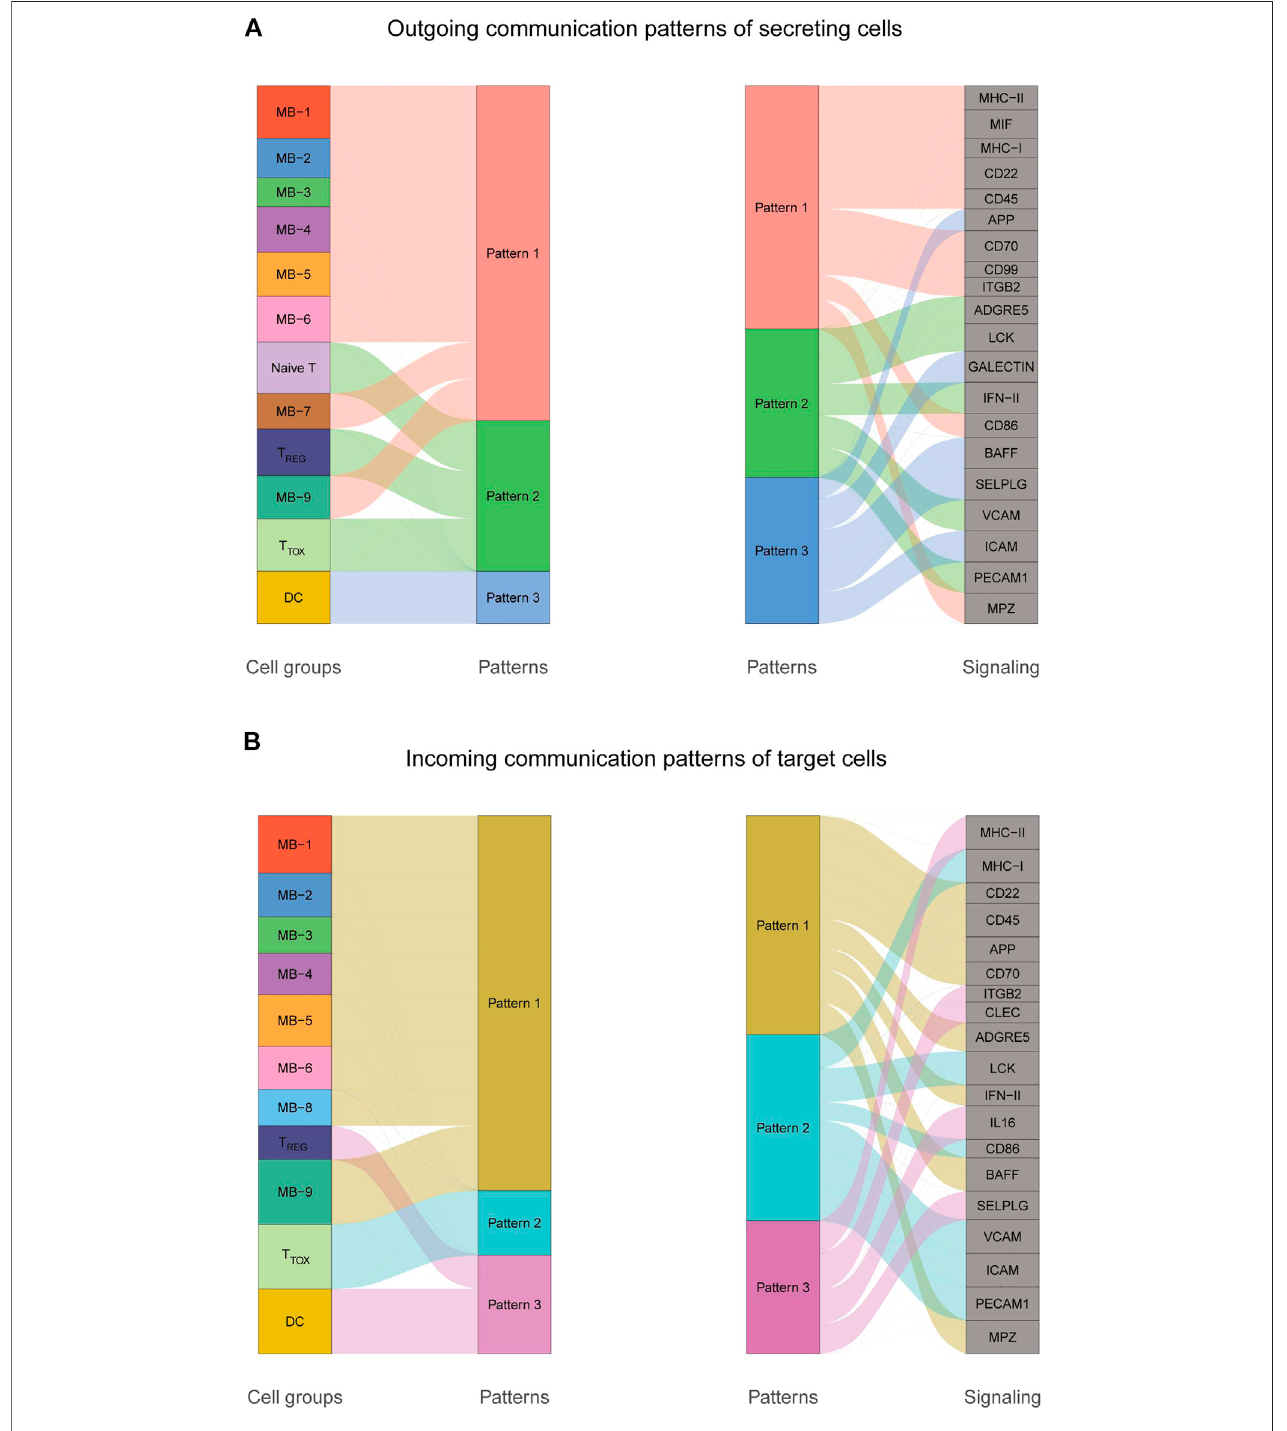
FIGURE 5 | Cellular communication patterns in DLBCL. (A) Visualization of outgoing communication patterns of secretory cells by alluvial plots showing the correspondence between inferred potential patterns and cell populations, as well as signaling pathways. The thickness of the fl ow indicates the contribution of the cell population or signaling pathway to each potential pattern. The height of each pattern is proportional to the number of cell populations or signaling pathways associated with it. Outgoing communication patterns reveal how sending cells coordinate with each other and how they coordinate with certain signaling pathways to drive communication. (B) Incomingcommunicationpatternsoftargetcells.Incomingcommunicationpatternsrevealhowtargetcellscoordinatewitheachotherandhowthey coordinate with certain signaling pathways in response to incoming signals.